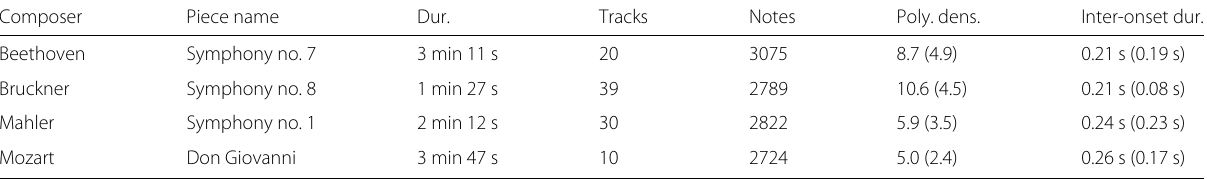
Table 2 Characteristics of the orchestral dataset used for the evaluation of our SS system